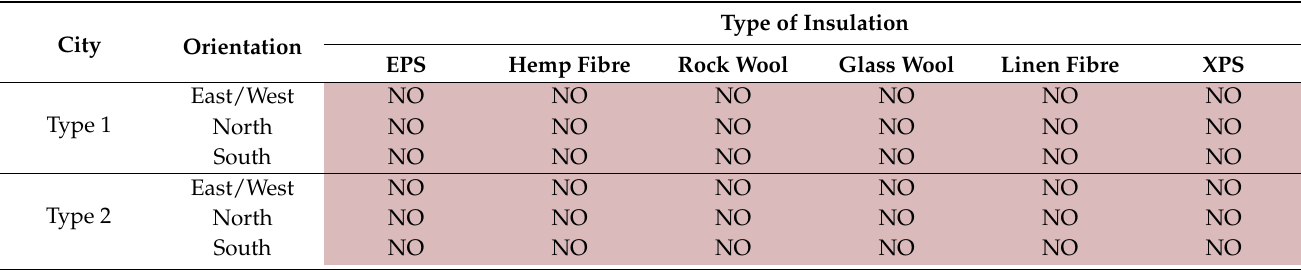
Table 7. Results of the values of the presence of interstitial condensation divided by building type and orientation.